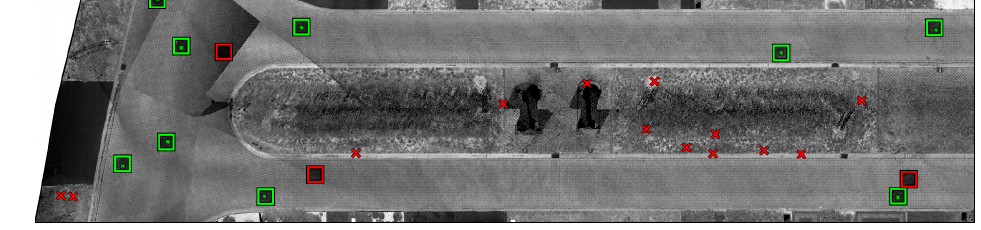
( c ) VGG16 trained on dataset 1 with IHV images with localization parameters T class = 0.3 and T cluster = 17.